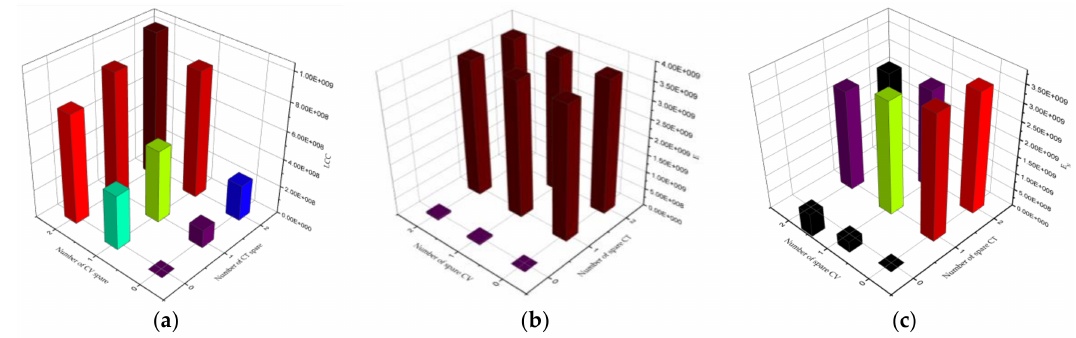
Figure 7. Cost-benefit analysis: ( a ) LCC in different redundant configuration; ( b ) E in different redundant configuration; ( c ) E N in different redundant